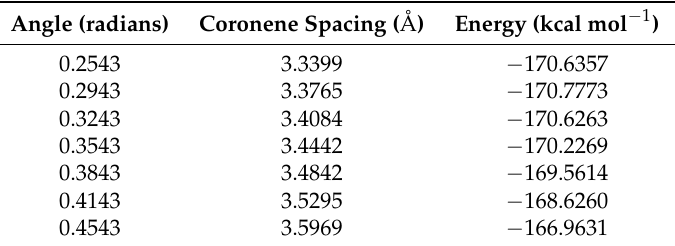
Table 4. Minimum energy intermolecular spacings corresponding to given angles for stack of three coronene encapsulated within ( 19,0 ) nanotube.